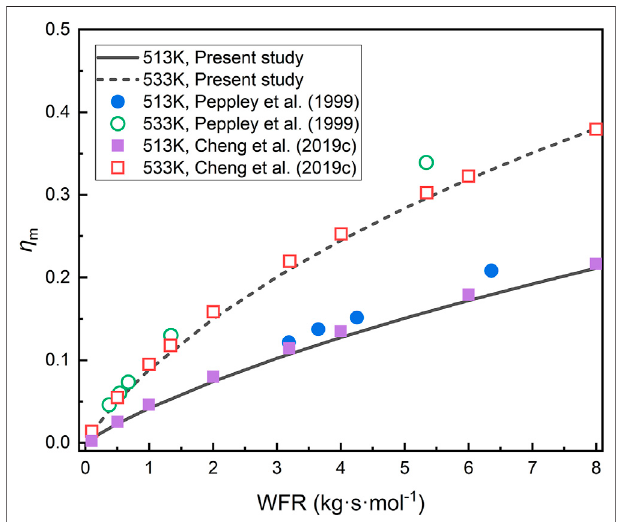
FIGURE 4 | Comparative veri fi cation of the chemical part with the experimentalresults(Peppley etal.,1999)andsimulation results(Chengetal., 2019c).